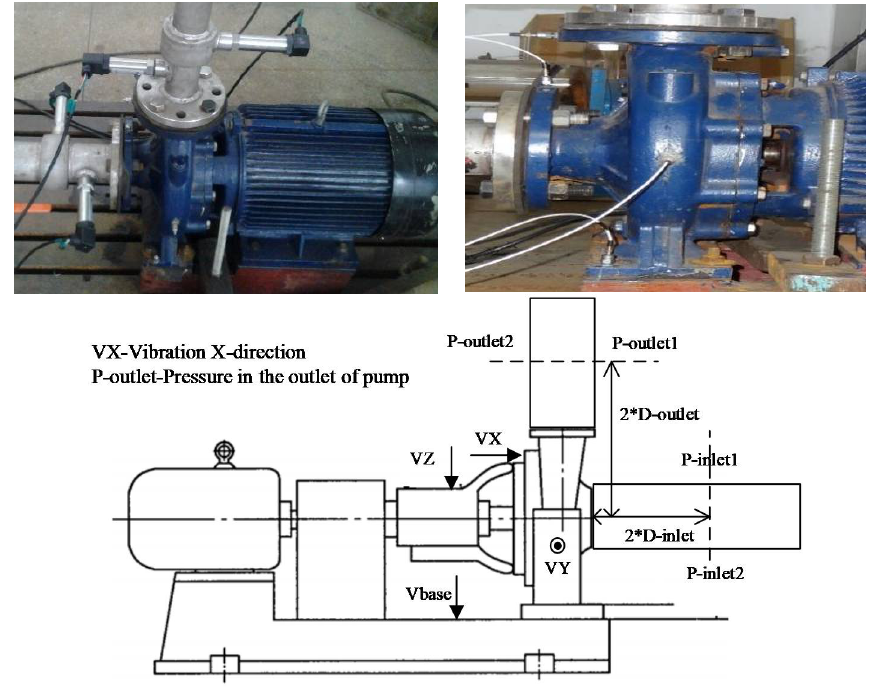
Figure 4. Performance monitoring sensors installation.